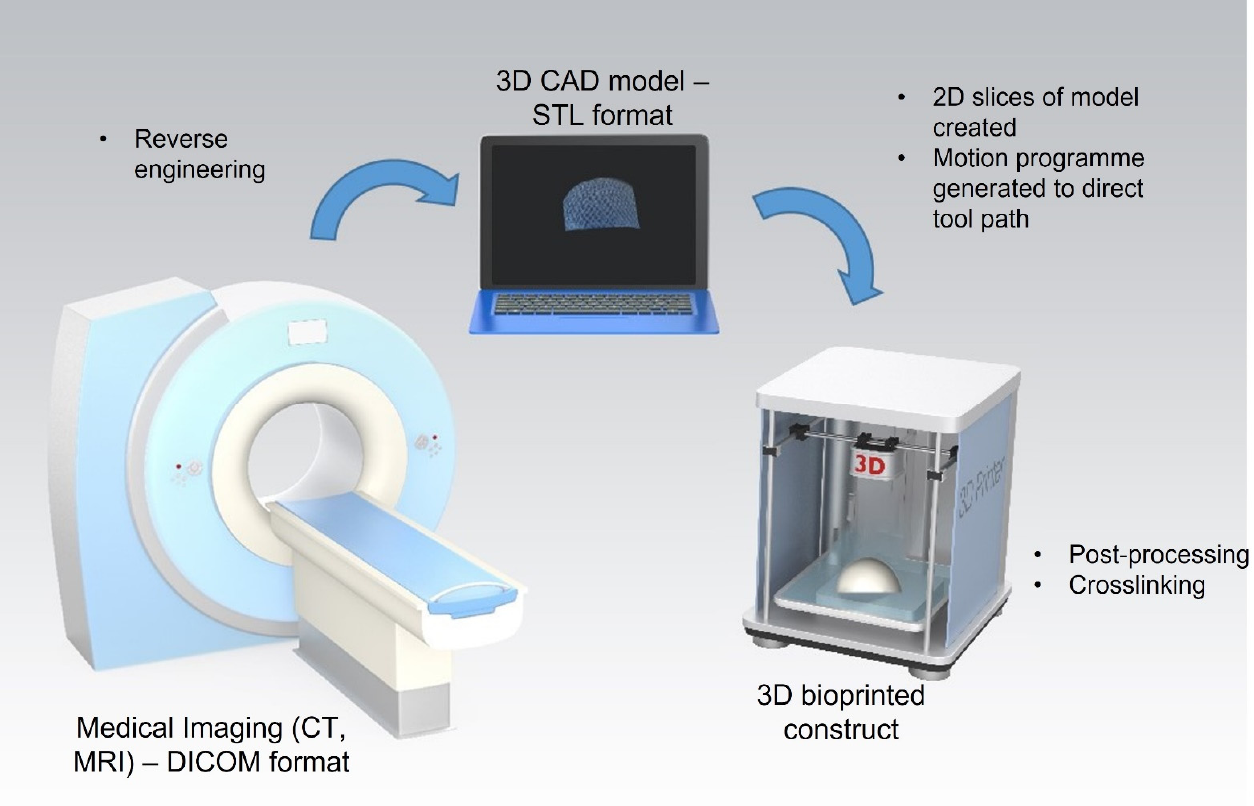
Figure 3. Process for 3D bioprinting of patient specific constructs for cartilage tissue engineering applications. Stage 1: 3D image of cartilage defect captured using computed tomography (CT) or magnetic resonance (MRI) and stored in the Digital Imaging and Communications in Medicine (DICOM) format. Stage 2: DICOM file is reverse-engineered and imported into computer-aided design (CAD) software and then converted into an STL file. Stage 3: A motion programme is created to provide the tool path information for the printer. The desired construct is bioprinted in a layer-by-layer fashion and post-processing/crosslinking applied.